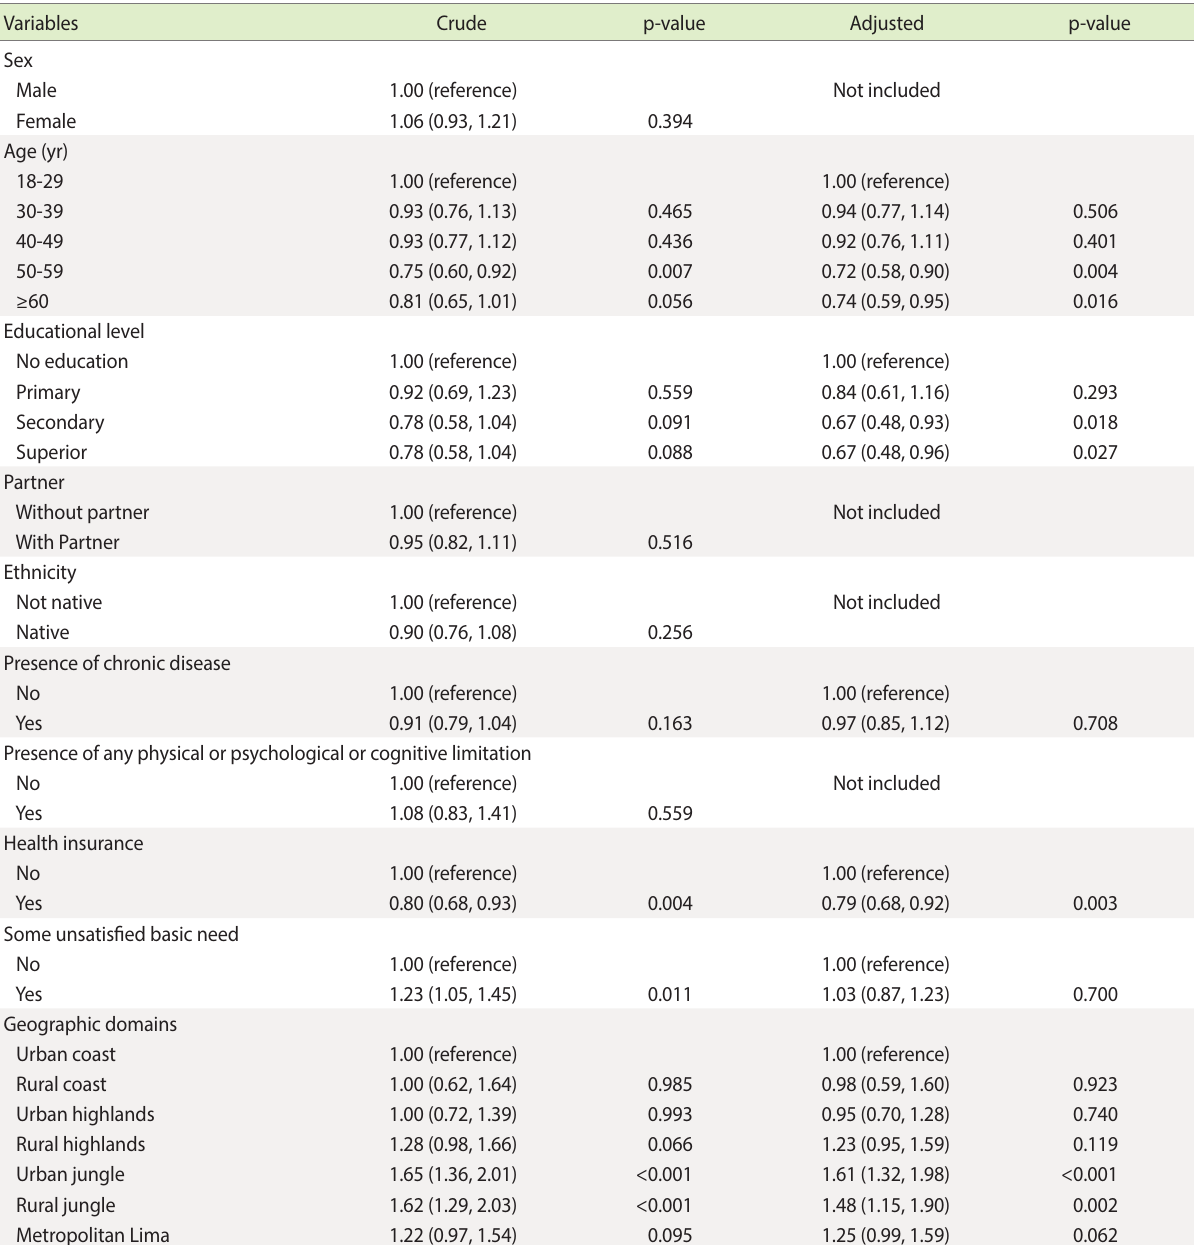
Table 2. Crude and adjusted prevalence ratios of non-utilization of health services in persons with COVID-19 symptomatology 1